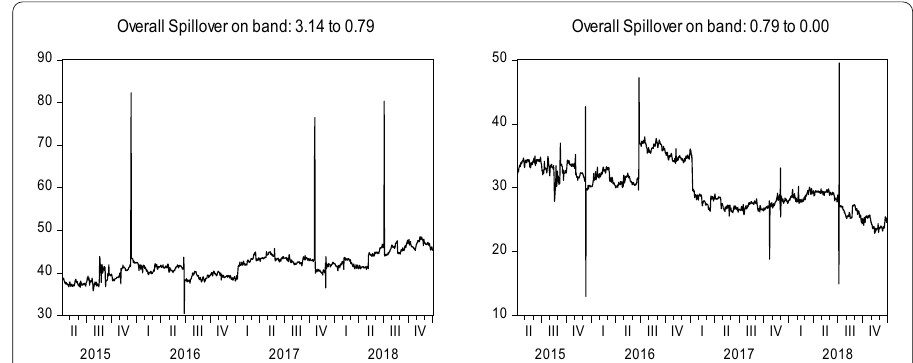
Fig. 5 Time varying frequency connectedness of the Bitcoin markets and foreign exchange pairs of major trading currencies. Band 3.14 to 0.79 corresponds 1 to 4 days (Short Horizon) and band 0.79 to 0.00 corresponds 4 plus days to infinity (Long Horizon). The Y-axis depicts the volatility spillover values and the X-axis depicts the time